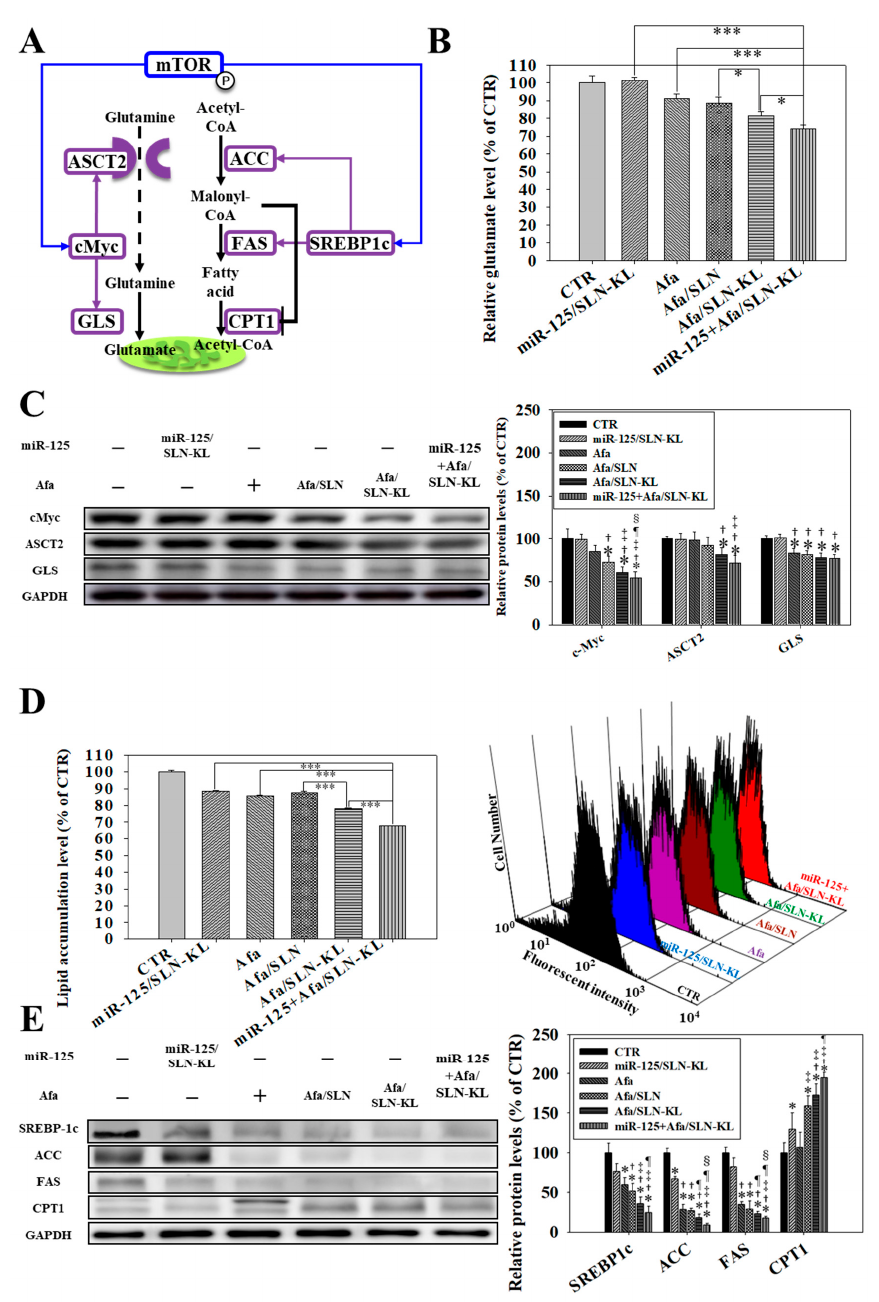
Figure 5. Effects of various formulations of miR-125 (100 nM) and/or Afa (300 nM) for 24 h on the pathways of glutaminolysis and fatty acid metabolism in AGS cells. ( A ) Scheme of glutaminolysis and fatty acid metabolism. ( B ) Measurement of relative glutamate levels by using a multifunctional microplate reader (statistical significance at * p < 0.05; *** p < 0.001). ( C ) ( Left ) Effect of various formulations of Afa and/or miR-125 on the expression of glutaminolysis pathway. ( Right ) Quantification of relative protein levels of glutaminolysis pathway. ( D ) ( Left ) Measurement of lipid accumulation by measuring a fluorescent lipid probe (4,4-Difluoro-1,3,5,7,8-Pentamethyl-4- Bora-3a,4a-Diaza-s-Indacene; BODIPY™; 100 mM) using a flow cytometer (statistical significance at *** p < 0.001). ( Right ) Histogram plots of fluorescence distribution of BODIPY™ after various treatments in AGS cells. ( E ) ( Left ) Effect of various formulations on protein expression in the pathway of fatty acid metabolism. ( Right ) Quantification of relative protein levels of fatty acid metabolism pathway. ( C , E ) * p < 0.05 compared with CTR, † p < 0.05 compared with miR-125/SLN-KL, ‡ p < 0.05 compared with Afa, ¶ p < 0.05 compared with Afa/SLN, and § p < 0.05 compared with Afa/SLN-KL via Student’s t -test